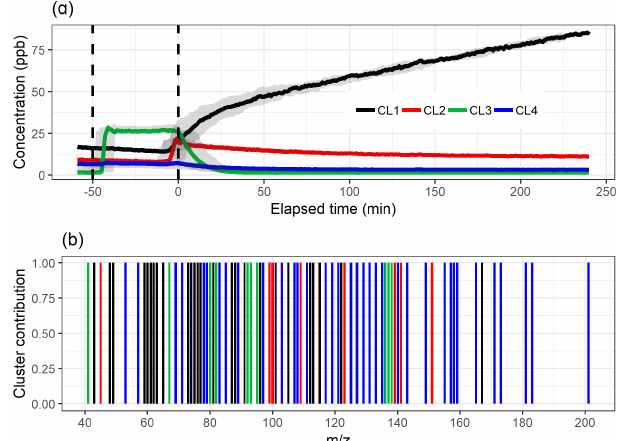
Figure 5. The time series (a) of the clusters and the distribution of ion to clusters (b) from PAM with four-cluster solution. Shaded areas in the time series indicate the cluster range for the bootstrap resamples; solid lines are for the measured gas-phase (PTR-MS) data. The colour code identifying clusters is the same in both pan- els. Clusters were identified as later-forming and slowly forming products (CL1), early products (CL2), α -pinene precursor (CL3), and background or car exhaust precursor (CL4).